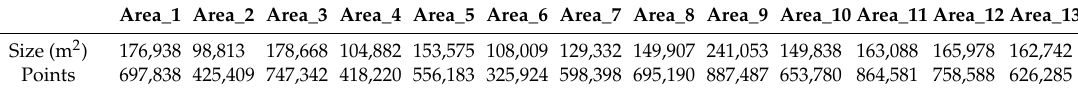
Table 2. Specifications of the Titan Airborne System.